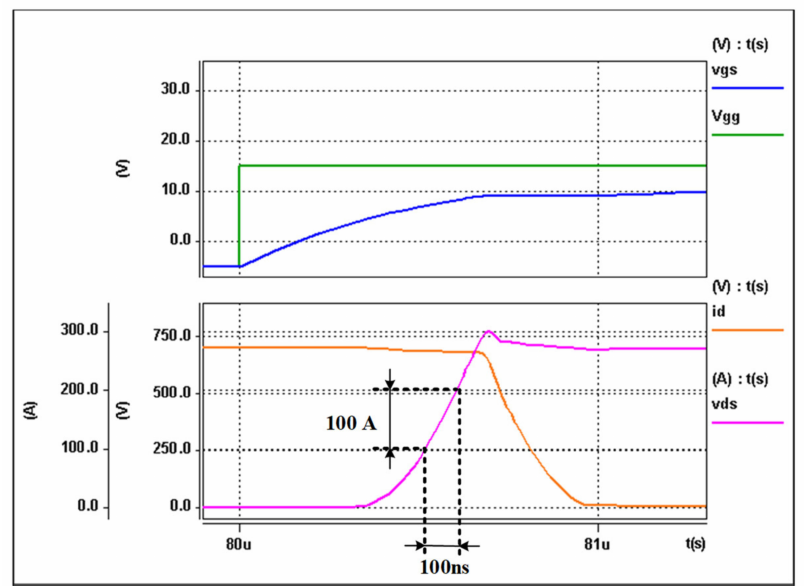
Figure 4. The turn-on cycle of the SiC MOSFET from module CAS300M17BM2 using conventional gate driver (CGD). V DD = 700 V, I 0 = 270 A, V GG = 15